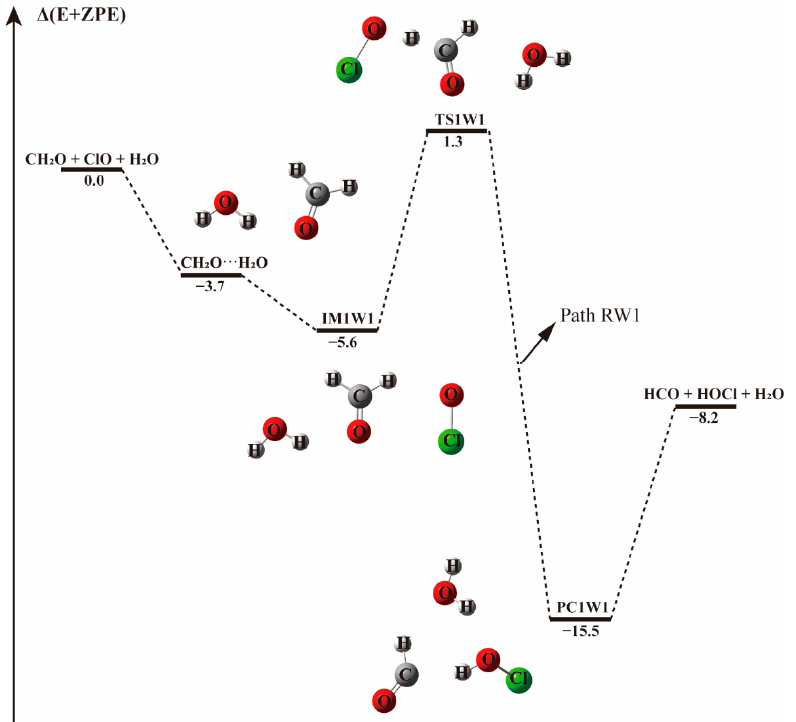
Figure 4. The energy profile of the CH 2 O + ClO water-involved reaction occurring through the CH 2 O···H 2 O + ClO pathway. Energies (in kcal mol − 1 ) are calculated at the CCSD(T)/aug-cc-pVTZ//B3LYP-D3/aug-cc-pVTZ level.